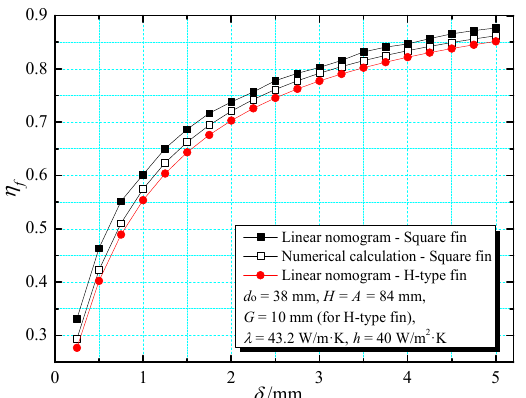
Figure 11. Influence of the fin thickness on the fin efficiency of H-type and square fins.